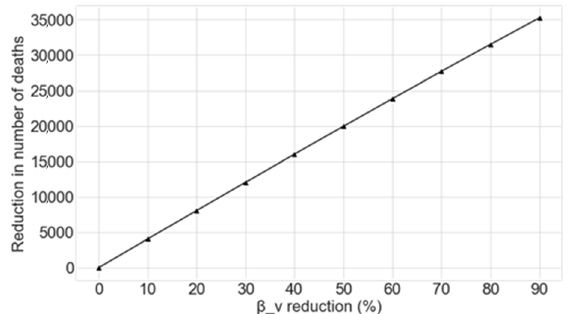
Figure 5. Reduction in the number of deaths as a function of the percentage decrease in β v for the best fit model, given that this reduction is applied at the beginning of the outbreak.